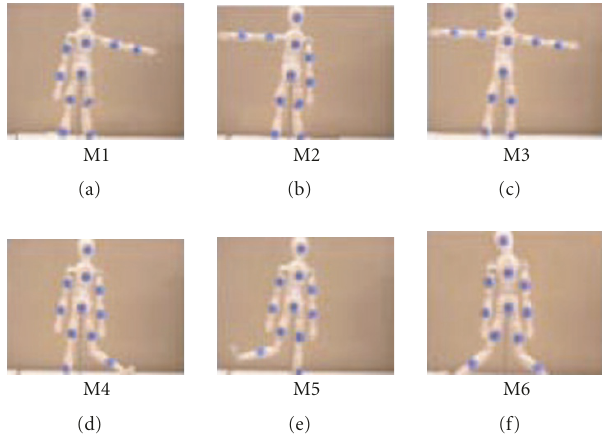
Figure 8: Six behavioral tasks of the humanoid.